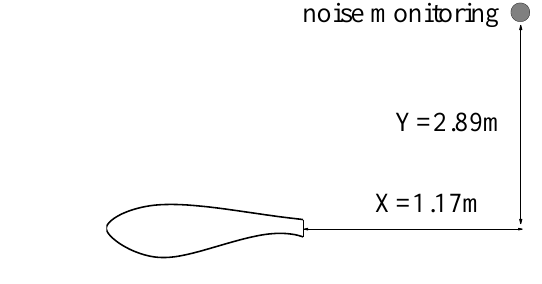
Figure 6. Position of noise monitoring point.